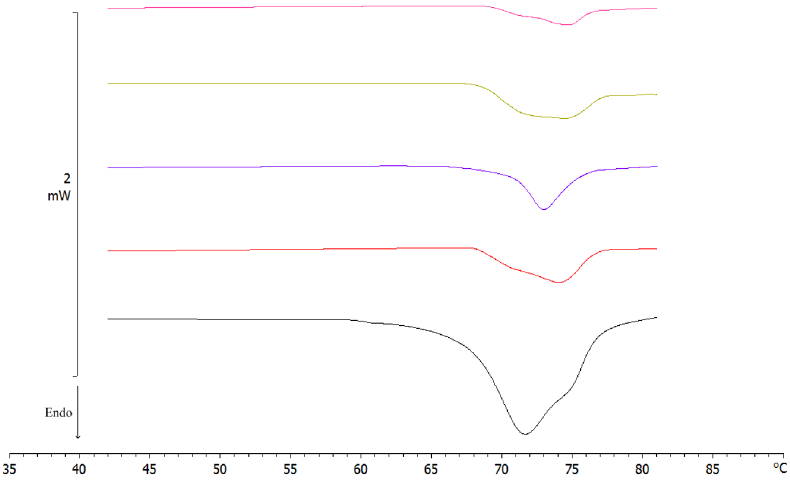
Figure 7. DSC thermograms of pre- and post-lyophilized SLNs. Pre-lyophilization SLN (black); SLN G 0 (red); SLN G 1 (blue); SLN G 3 (yellow); SLN G 4 (pink). Table 5. Enthalpy variations ( H) and peak temperatures of rapidly resuspended SLNs and pre- lyophilization SLN.